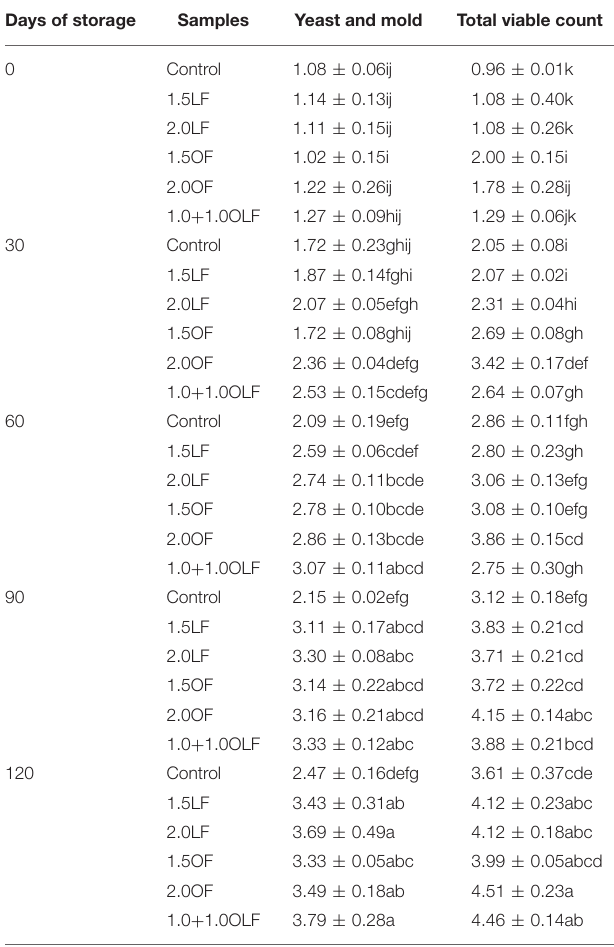
TABLE 8 | Mean log 10 of microbial population counts of breads produced using various doses and types of citrus fibres during storage. Days of storage Samples Yeast and mold Total viable